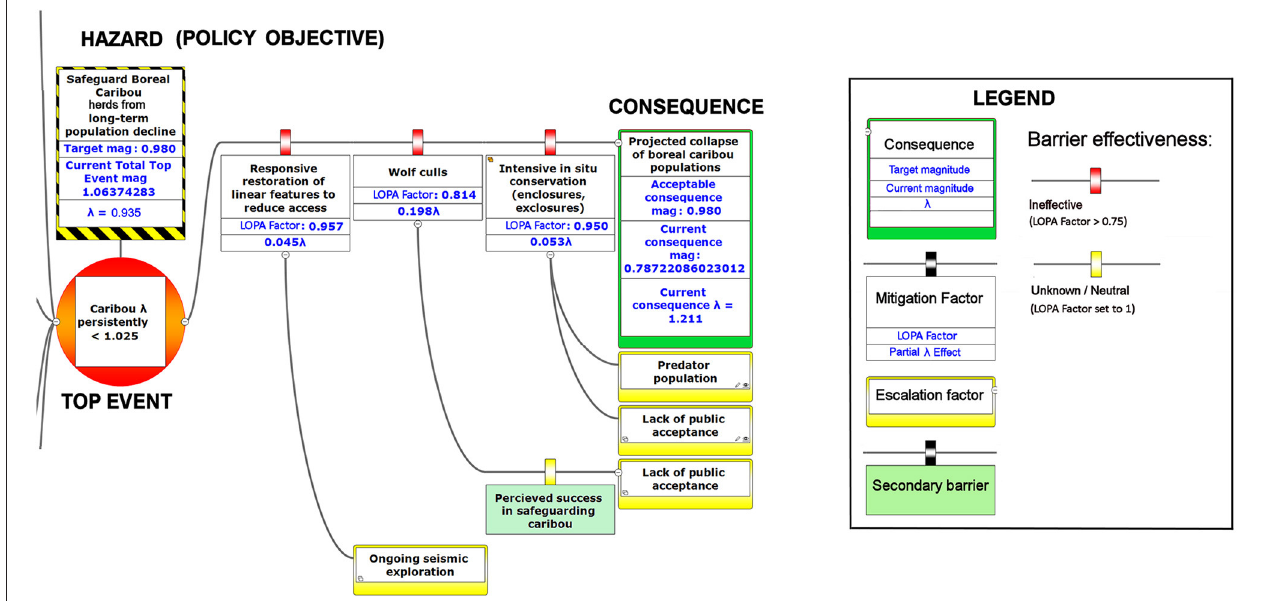
FIGURE 8 | The right-hand portion of a bow-tie diagram that visualizes cumulative environmental threats to the boreal caribou meta-population. The top event (red circle, left) is a circumstance where the population growth rate of caribou ( λ ) persistently falls below 1.025. The outcome of the top event is shown in the green box at right; the unchecked consequence of an occurrence of the top event would be a reduced meta-population that could ultimately be extirpated. Potential mitigating factors are indicated in boxes between the top event and the outcome. Yellow boxes show risk escalation factors that may reduce barrier effectiveness, and secondary barriers to those escalation factors, if present. The numbers appearing in the mitigation boxes correspond to the mean current probability-based LOPA factor for barrier or mitigation failure for the Chinchaga herd (1.0 = 100%; greater values compensate for natural vs. altered conditions and unfactored threat incidence). The top event and consequence boxes contain target values for sustainable thresholds. To assist with visual interpretation of the LOPA figures, the barriers are color-coded according to the LOPA factor (green = 0.01–0.25, light green = 0.25–0.50, orange = 0.50–0.75, red = values > 0.75, yellow = unknown and set to 1.0 as default).